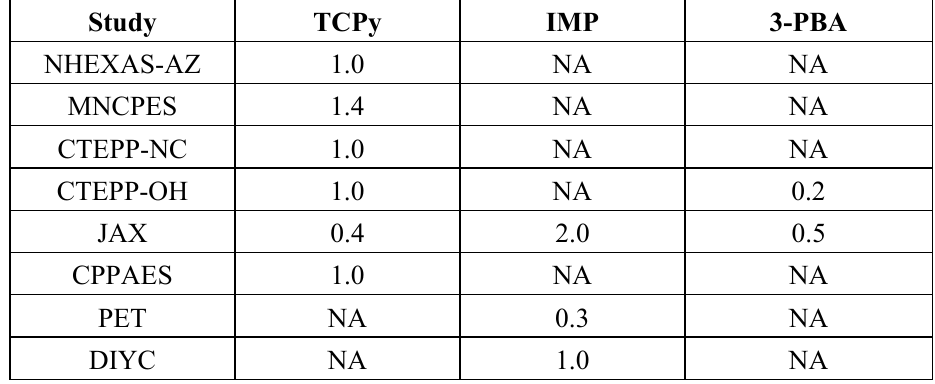
Table S-1. Limits of detection (ng/mL) for each pesticide metabolite measured in the children’s urine samples by